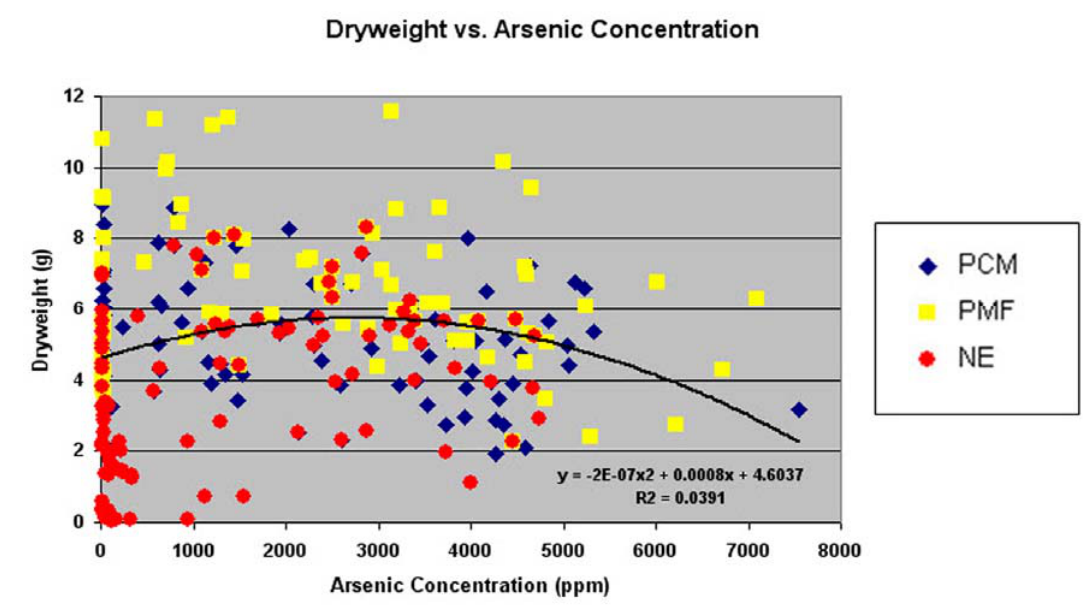
Figure 5. Arsenic concentration vs dryweight. The general relationships between arsenic and plant biomass for the non-accumulating control fern, Nephrolepis exaltata and for the two hyperaccumulating Pteris species. Even though the different species react differently, eventually arsenic is a stressor for all the